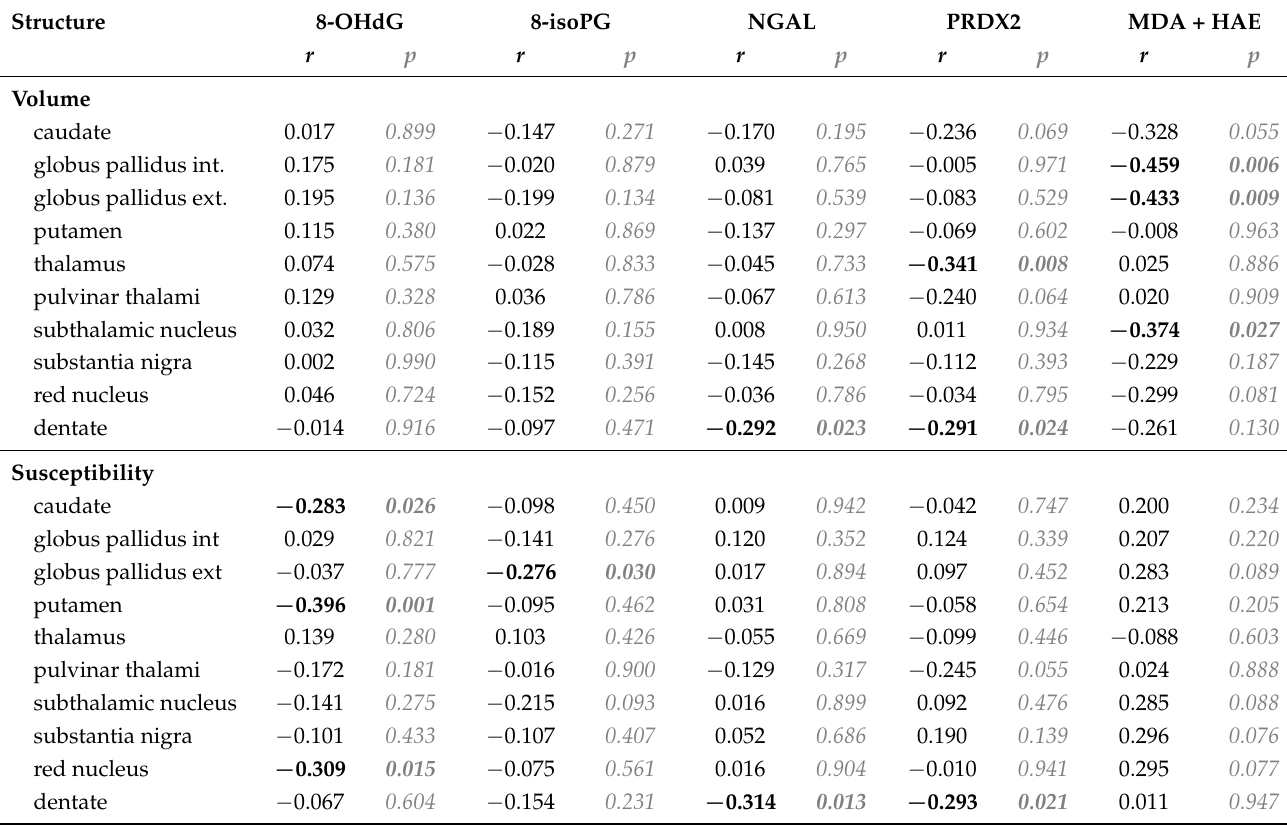
Table 3. Age and sex-adjusted partial correlation coefficients among biochemical markers and deep gray matter volumes and susceptibilities in early MS